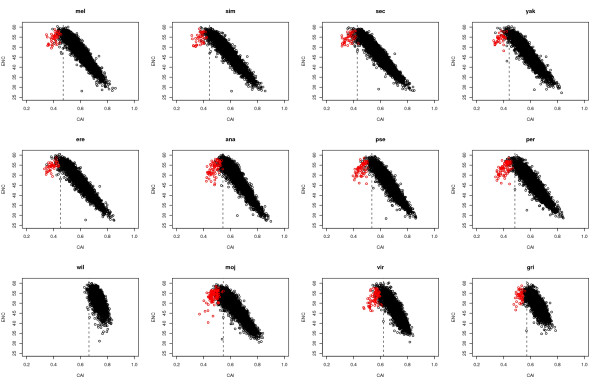
Scatter plot of CAI versus ENC values for each of the 12 genomes. The reference set for CAI is relative to each genome (see text for details). The red dots are the genes that are localized in the fourth chromosomes (element F) in D. melanogaster. The dashed line indicates the CAI index value that a gene with equal codon usage (no CUB) would have, which occurs when mutation bias to A/T is exactly balanced by selection to G/C. One interpretation of these graphs is that genes to the right of the dashed lines are dominated by selection for codon usage, whereas genes to the left are dominated by mutation bias.